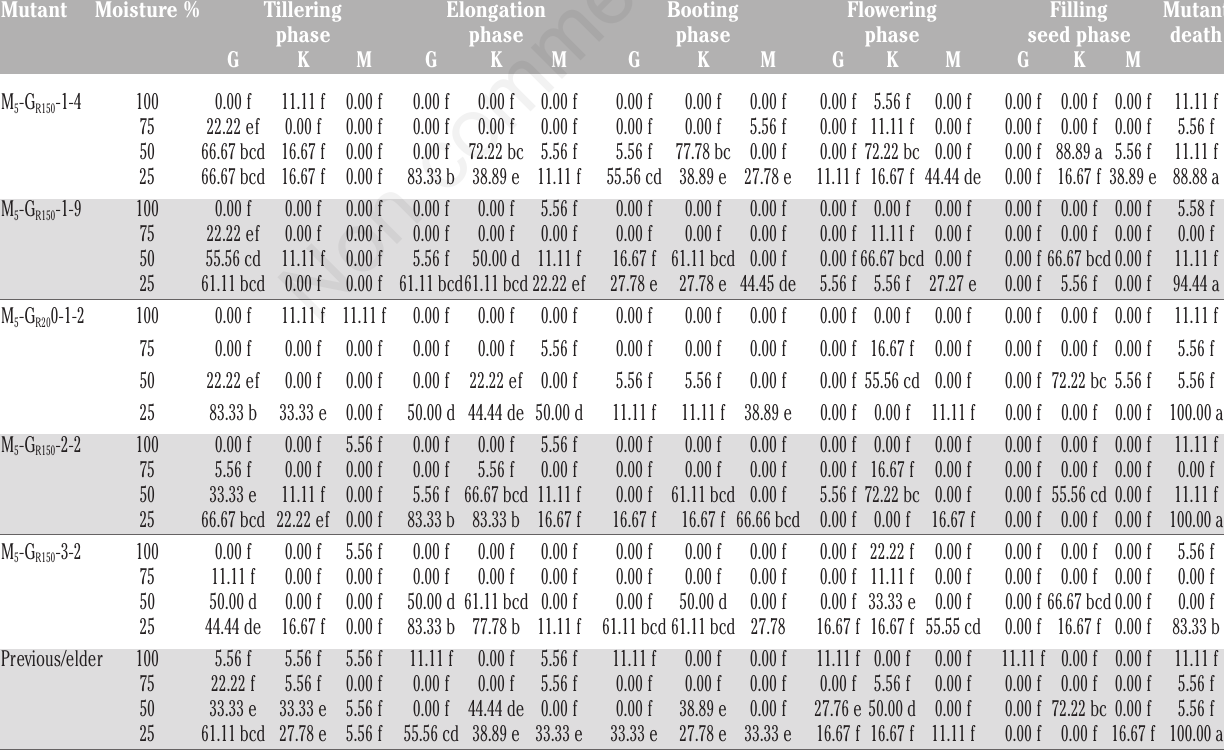
Table 3. Scrolling, drying and mutants death (M5) percentage to a few test of soil moisture (%). Mutant Moisture % Tillering Elongation Booting Flowering Filling Mutant